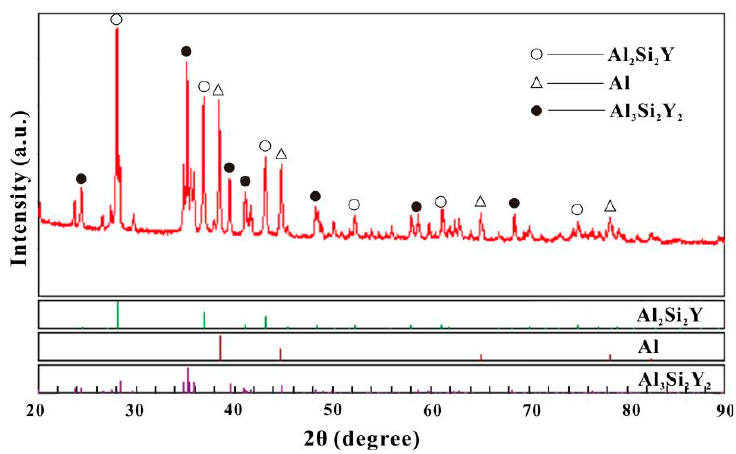
Figure 5. XRD pattern of alloy sample No. 36.